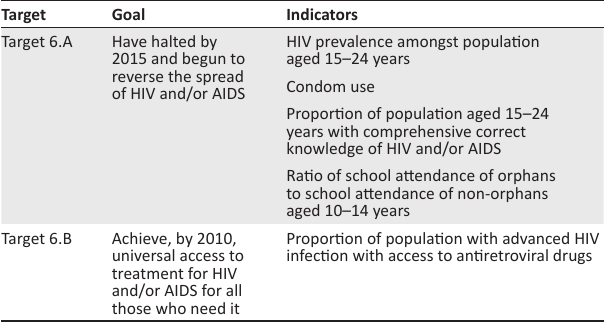
TABLE 2: Millennium development goal 6 indicators. Target Goal